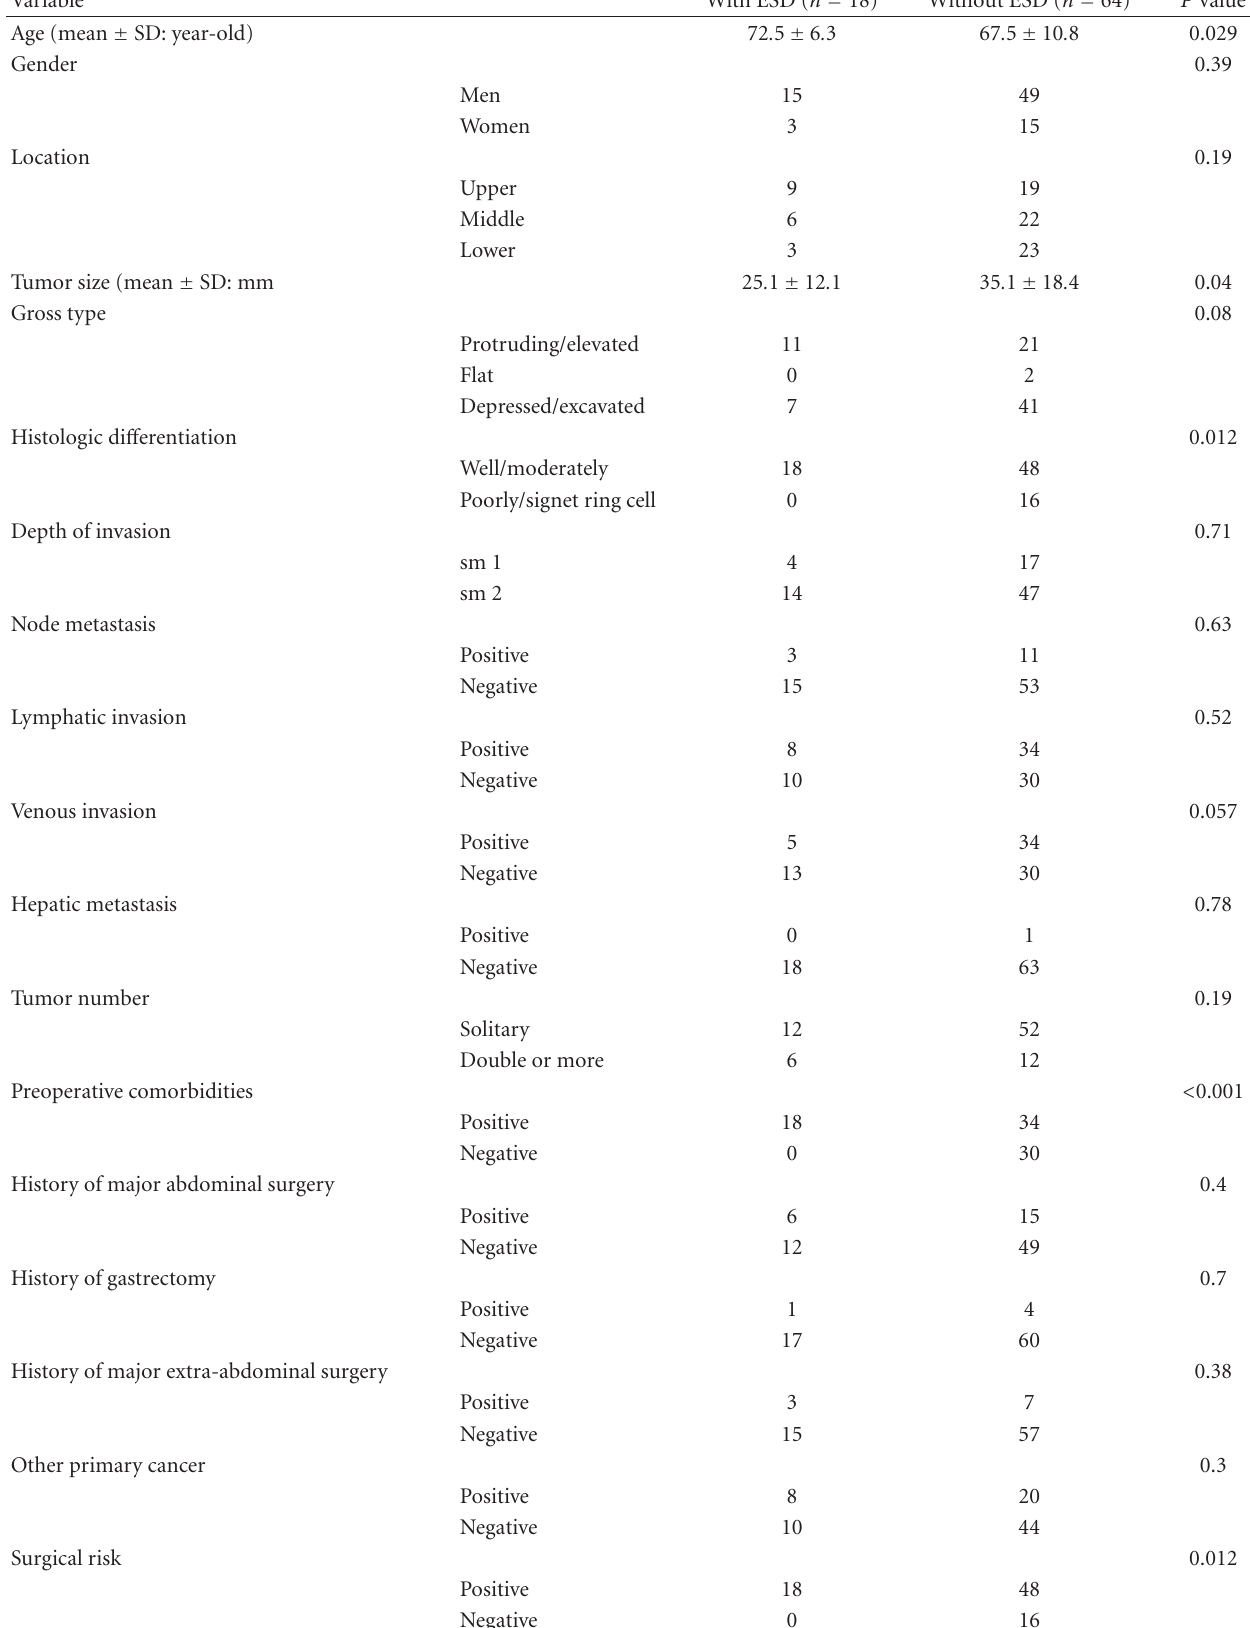
Table 3: A Comparison of the clinicopathologic features of gastrectomized patients with and without ESD.